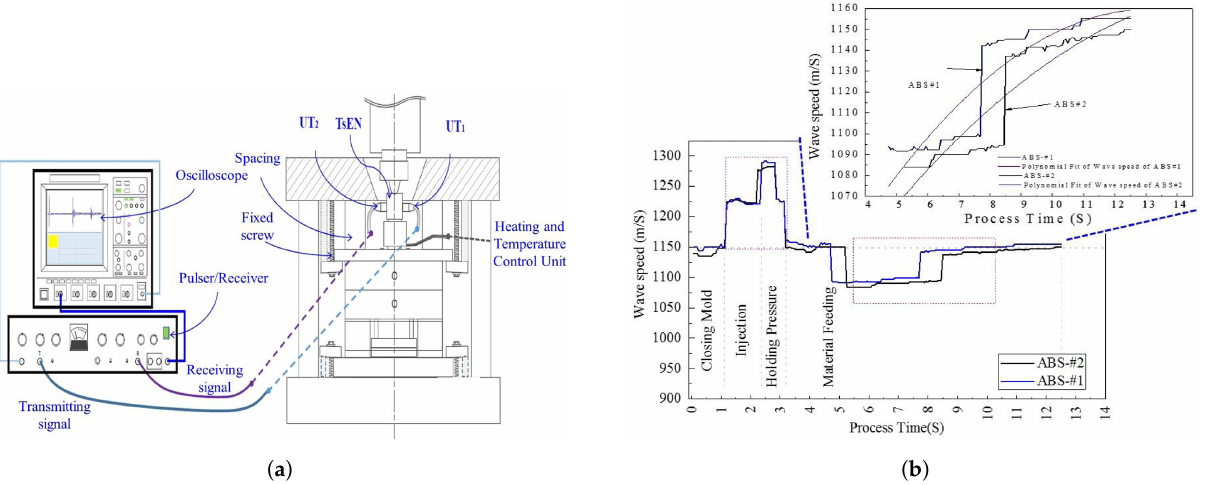
Figure 10. Fabricated sol-gel ultrasound sensor at the extension nozzle; ( a ) the T-shaped extension nozzle and data acquisition system for ultrasound sensor; ( b ) ultrasonic velocity vs. process time for ABS#1 & ABS#2 with different injection speed